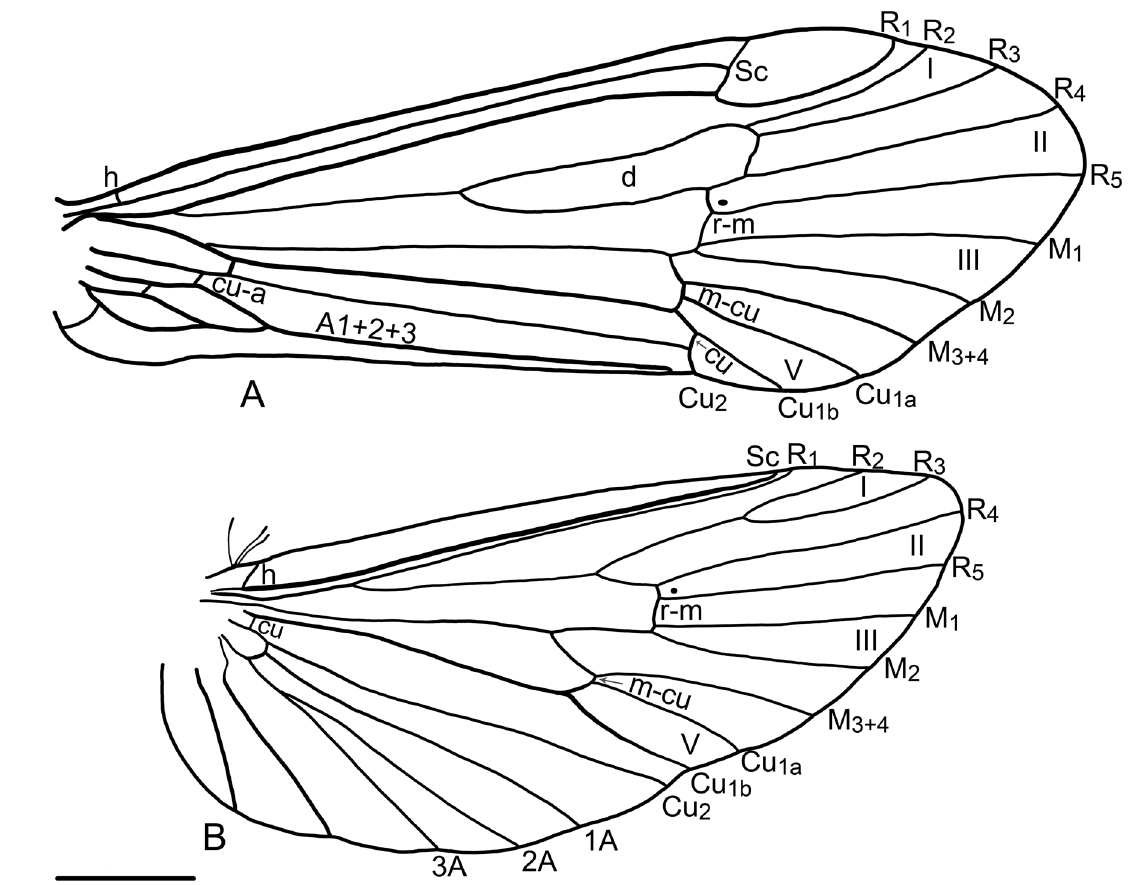
Fig. 3. Apatidelia morsei Xu & Sun sp. nov. A . Fore wing venation. B . Hind wing venation. Scale bar = 0.5